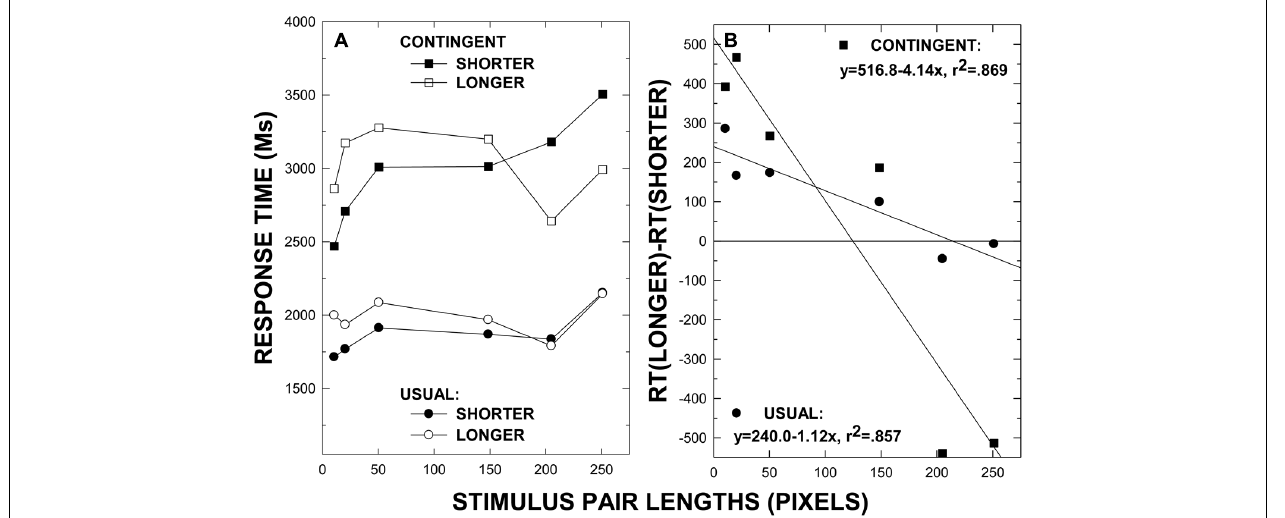
FIGURE 2 | Mean response times and standard error bars for each visual extent pair in Experiment 2 with each instruction in the usual and category-contingent instruction conditions (A). The semantic